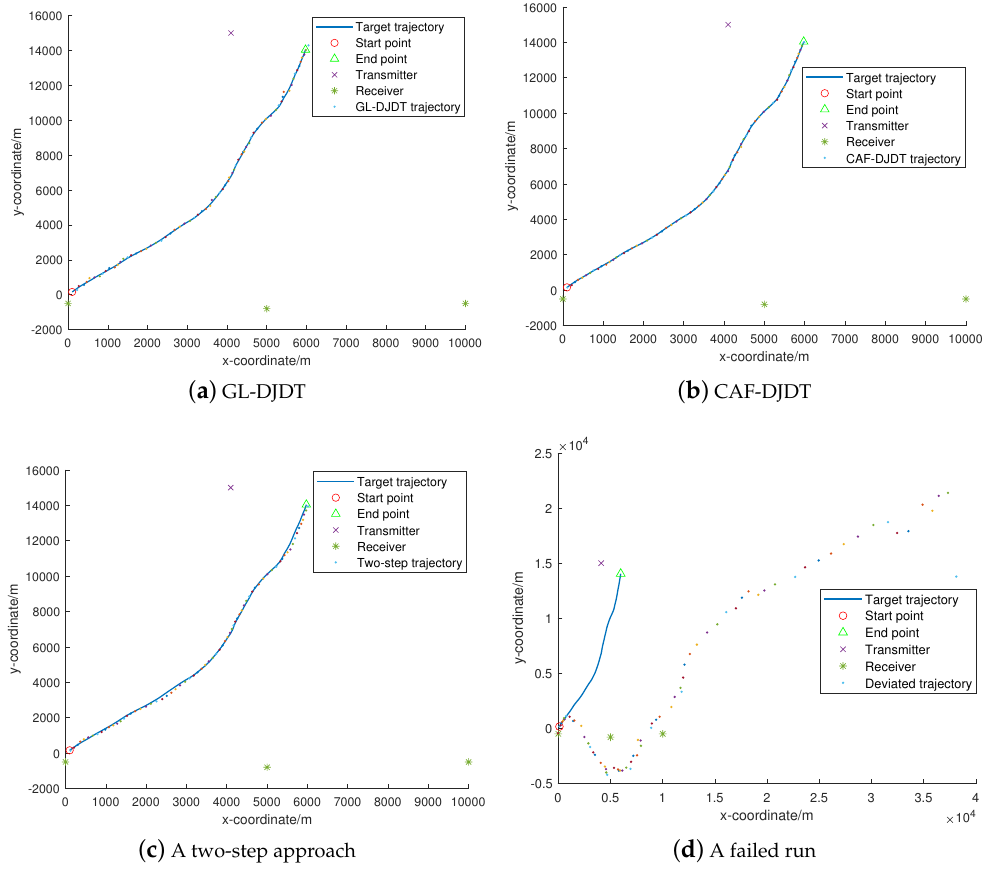
Figure 2. Simulated scenario and a typical Monte Carlo